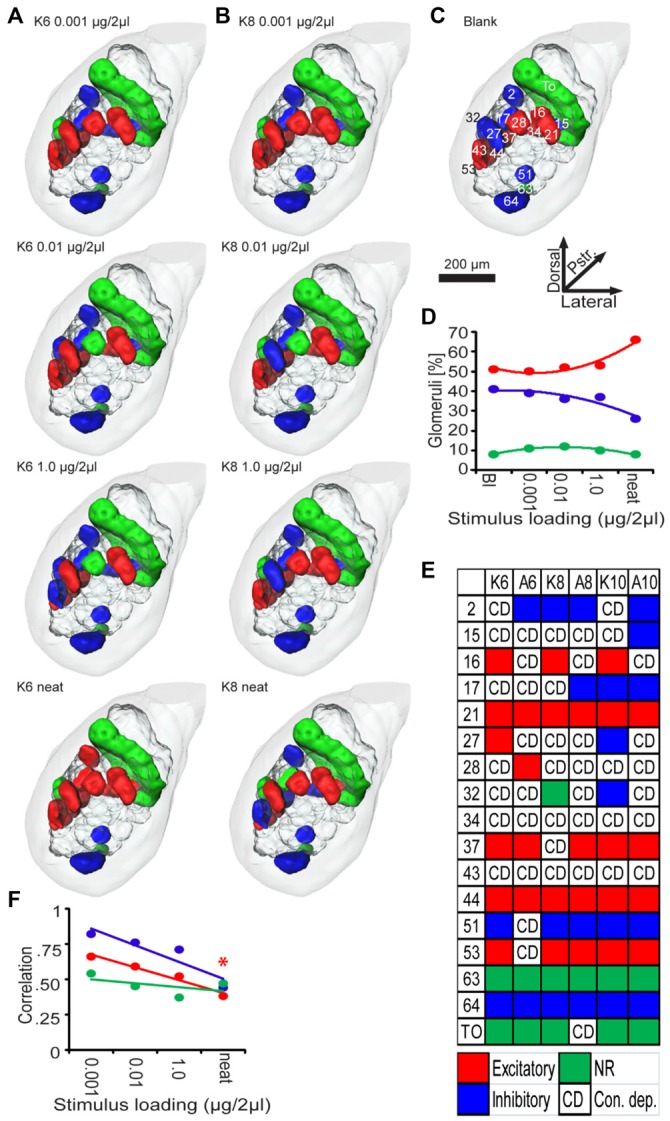
Odor and concentration dependent patterns of glomerular activity. Three-dimensional representations of AL responses to K6 (A) K8 (B) presented as a function of stimulus loading (in columns). (C) Three-dimensional representations of AL responses to the blank (no odor) stimuli. Glomeruli are color coded according to their z-score normalized spiking response during 0–500 ms peri-stimulus time window. Inset numbers and letters in (C) are the glomerular designations. Note that in response to different loadings of K6 or K8, a unique combinatorial pattern of excitatory output emerges; generally there are one or more glomeruli that change response type as well as a core of consistently responding glomeruli. (D) Mean percent of glomeruli responding as a function of stimulus loading from the blank (Bl) to neat (undiluted). Percentages are color coded blue, green, and red to indicate inhibitory, non-responsive and excitatory responses respectively. (E) Summary of responses of all glomeruli as a function of odor across stimulus loading. Each color coded box indicates which glomeruli (rows) responded consistently across all four loadings of a given odor (columns): Red, excited; blue, inhibited; green, non-responsive. CD indicates the response was concentration dependent. (F) Correlations between spatial patterns for different odors as a function of loading.